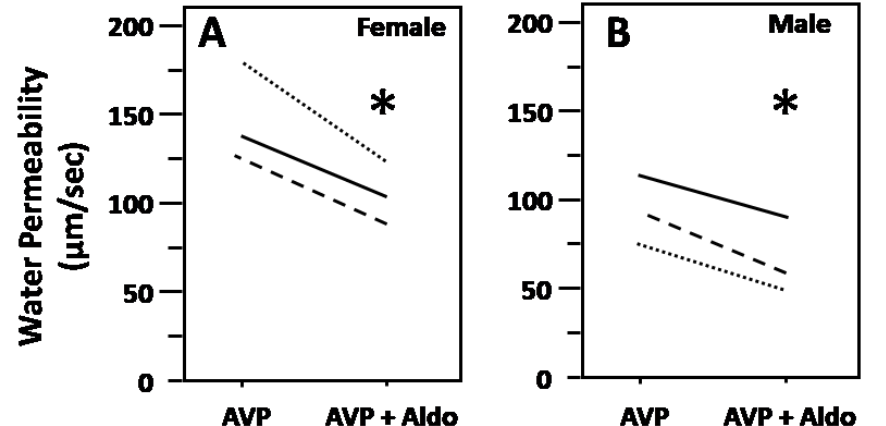
Figure 1. Aldosterone decreased vasopressin-stimulated osmotic water permeability in terminal inner medullary collecting ducts (IMCDs) from female ( A ) and male ( B ) rats. Terminal IMCDs were perfused with 50 pM vasopressin (AVP) for 20 min, samples were taken for analysis, then 500 nM aldosterone (Aldo) was added to the bath for 30 min, after which samples were taken for analysis. Each line represents a separate IMCD from a different rat. * P < 0.05 AVP control vs. AVP with Aldo, N = 3 rats/condition.